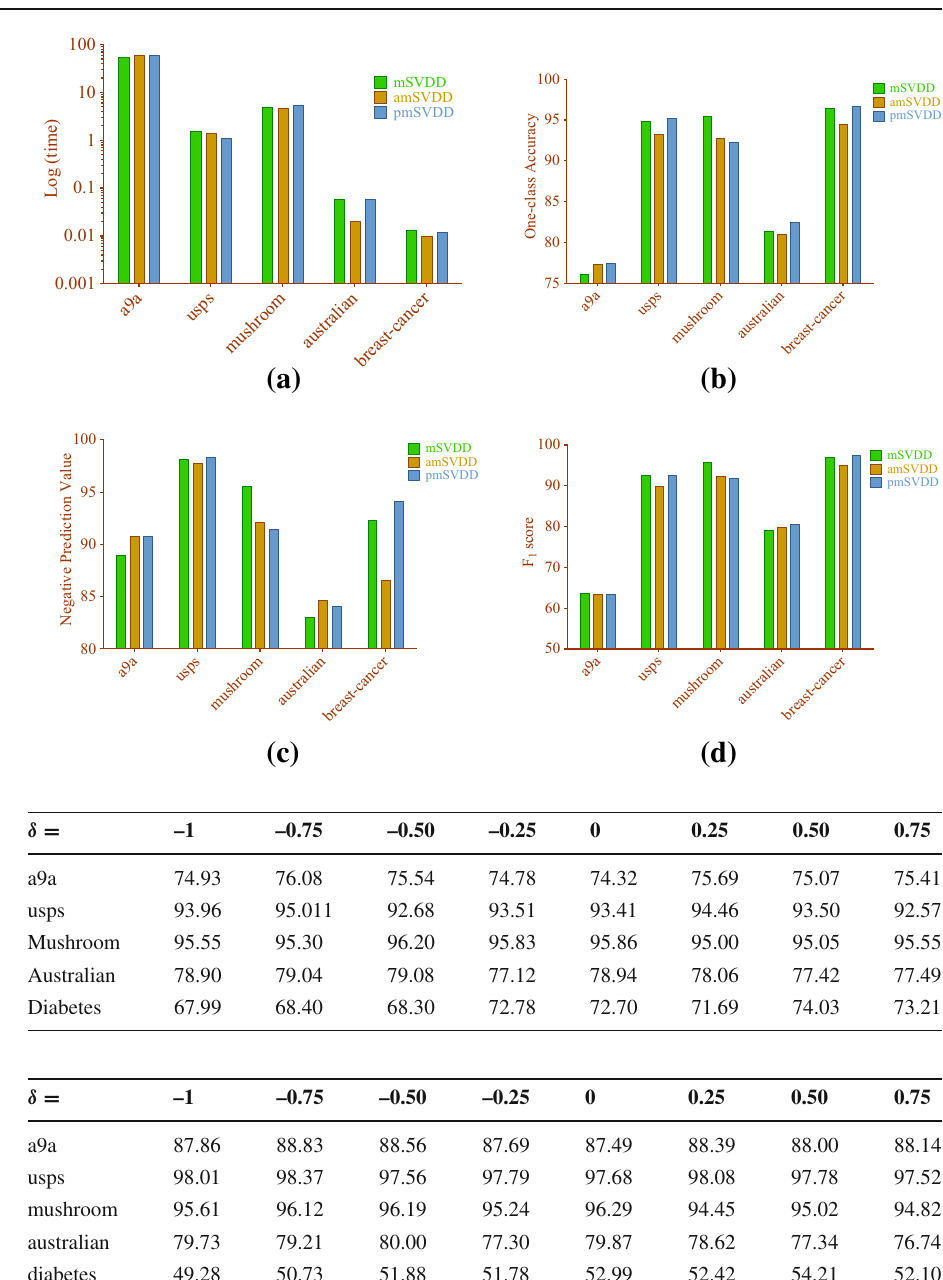
Fig. 6 Experimental results of the datasets on cross-validation. a Training times, b One-class accuracy, c negative prediction value, d F 1 score